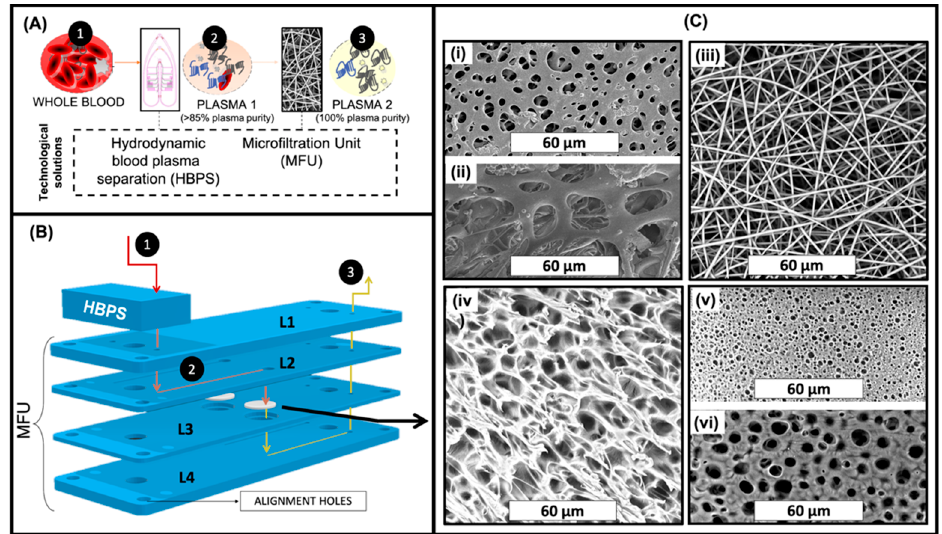
Figure 1 . ( A ) Schematic representation of the technical solution for a continuous hybrid blood plasma separation proposed in this work; ( B ) Schematic of the microfluidic device for a continuous RBCs separation proposed in this work. It is composed by a Hydrodynamic Blood Plasma Separation (HBPS) chip and by a Microfiltration unit (MFU); ( C ) SEM images of ( i ) back side and ( ii ) front side of Vivid ® membrane; ( iii ) ES membrane; ( iv ) TIPS membrane; ( v ) Back side; and ( vi ) Front side of DIPS